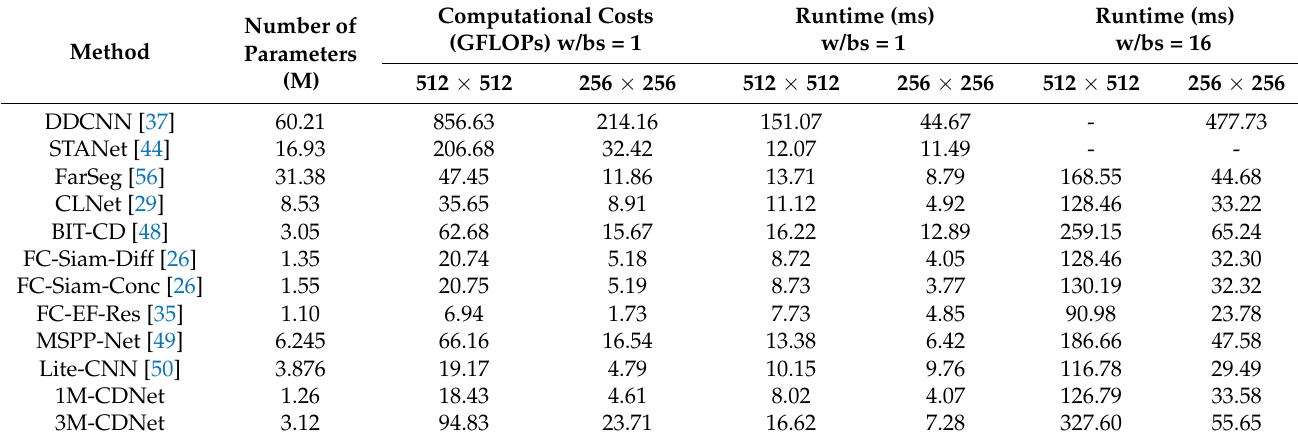
Table 4. Comparison of network parameters, computational costs, and runtime.